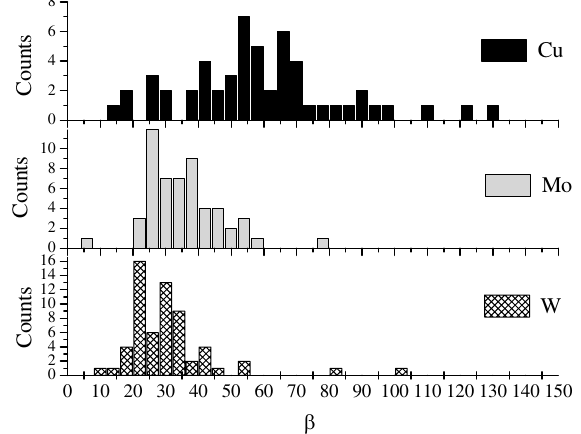
FIG. 5. Histograms of the field enhancement factor from various conditioning curves measured at different sites of the cathode for Cu, Mo, and W.